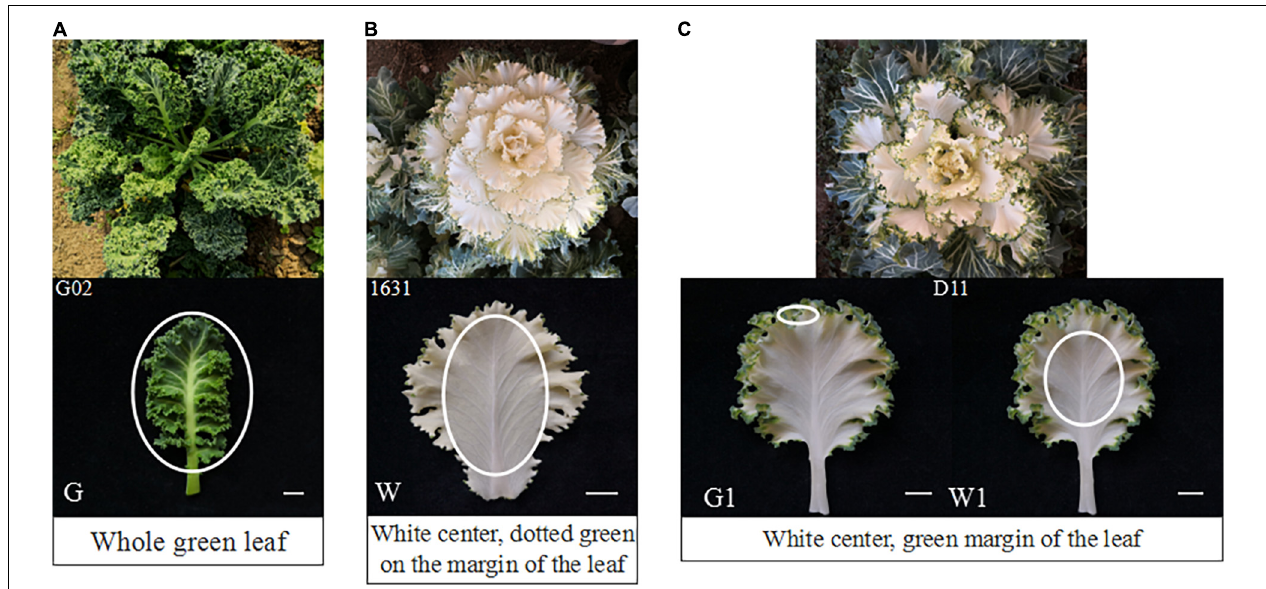
FIGURE 1 | Phenotypes and sampling sites of the three ornamental kale cultivars investigated. (A) Phenotype of ‘G02’. (B) Phenotype of ‘1631’. (C) Phenotype of ‘D11’. The white ovals indicate the sampling sites: G, ‘G02’ plant; W, white center of ‘1631’ plant; G1, green margin of ‘D11’ plant; W, white center of ‘D11’ plant. Scale bar represents 1